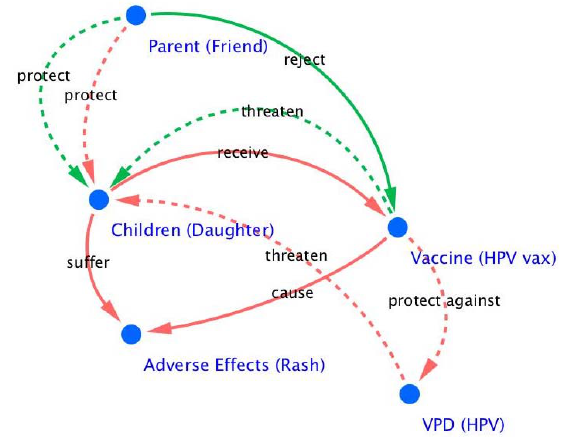
Figure 5. Partial activation of the “Vaccine Exemption” narrative framework in the reported story. Inferred relationships are presented as dotted lines for clarity. The embedded narrative is shown with red edges, while the frame narrative is shown with green edges.